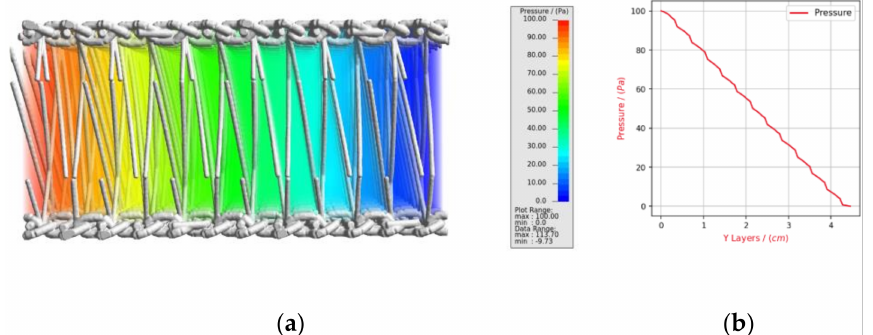
Figure 15. ( a ) GeoDict simulation of the horizontal flow in the spacer fabric. Pressure profile in the fluid with jumps on the vertical monofilament lattices; ( b ) snapshot taken in the middle point of the cross-section.